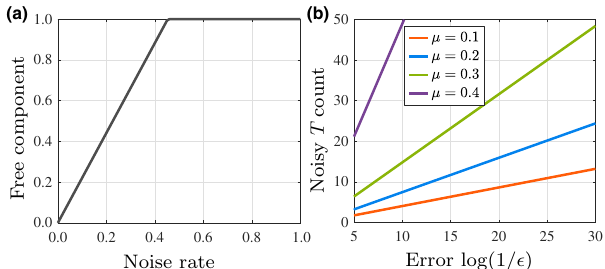
FIG. 4. Noisy Clifford+ T synthesis. (a) Free component of the noisy T gate N μ ◦ T , where T is followed by depolarizing noise of strength μ . (b) Lower bounds on the noisy T count (the number of N μ ◦ T ) needed to simulate a CCZ gate within diamond norm error (cid:12) , depicted for noise rates μ = 0.1, 0.2, 0.3,